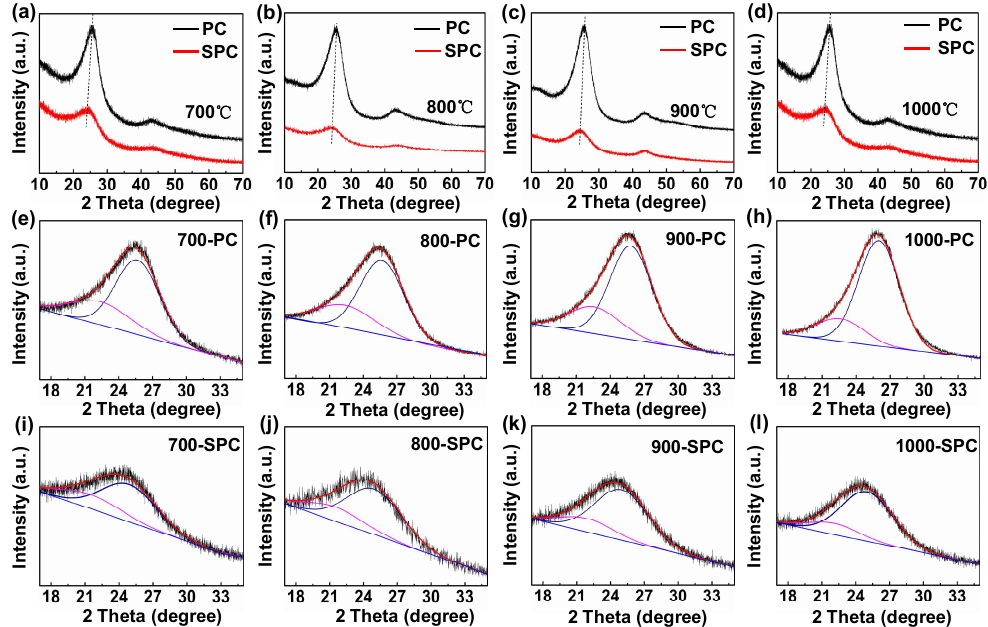
Figure 3. XRD results ( a – d ) and their fitting results of PC and SPC materials ( e – l ).